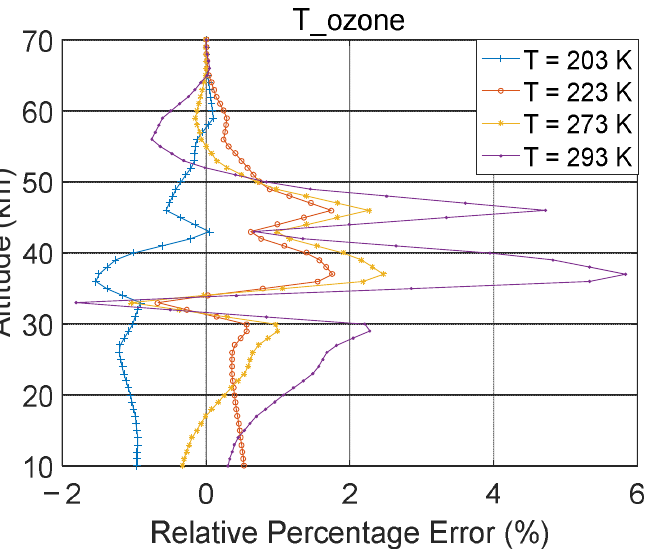
Figure 6. Relative errors of ozone concentration retrieved from ozone absorption cross sections at different temperatures.